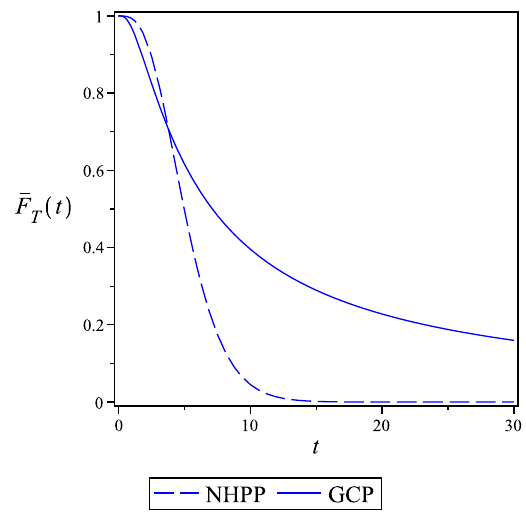
Figure 4. The reliability of network in Example